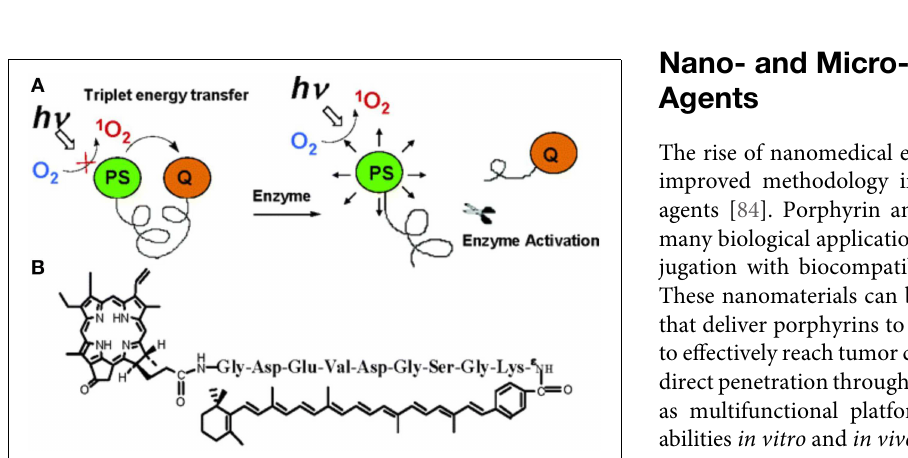
FIGURE 5 | Schematic representation of a dimer based photodynamic molecular beacon is shown on the left and the structure of Pc1 and Pc2 are shown on the right (Adapted with permission from Nesterova et al. [75]).